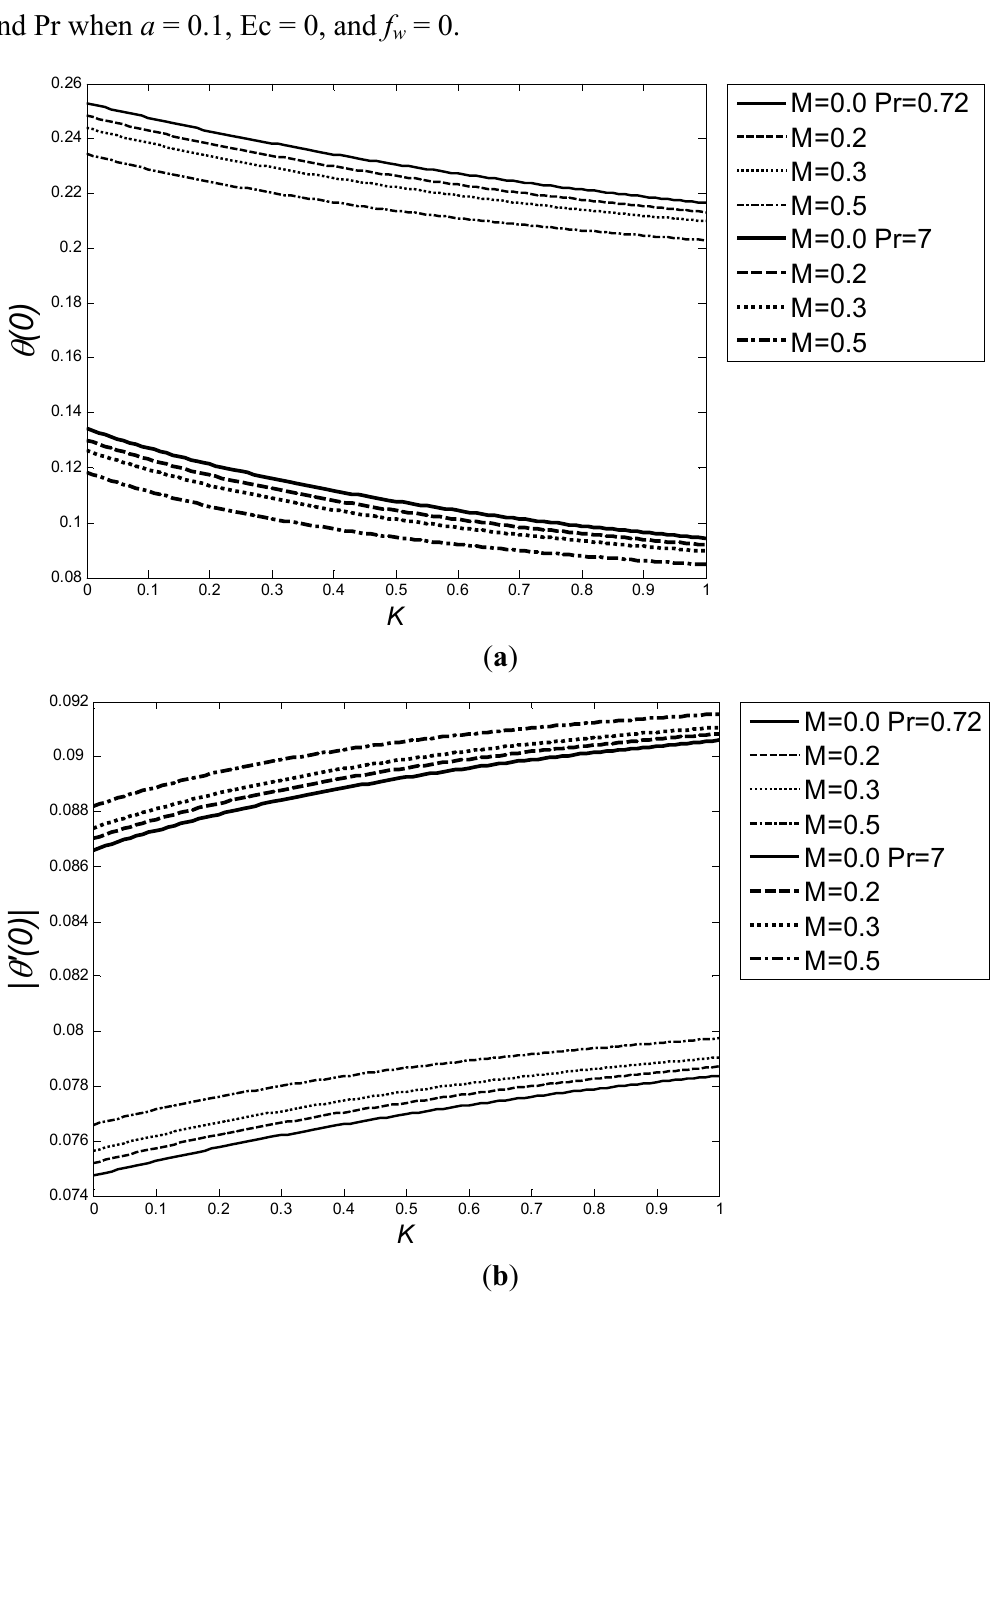
Figure 12. ( a ) Variation of the θ (0) and ( b ) | θ ' (0)| as a function of K for various values of M and Pr when a = 0.1, Ec = 0, and f